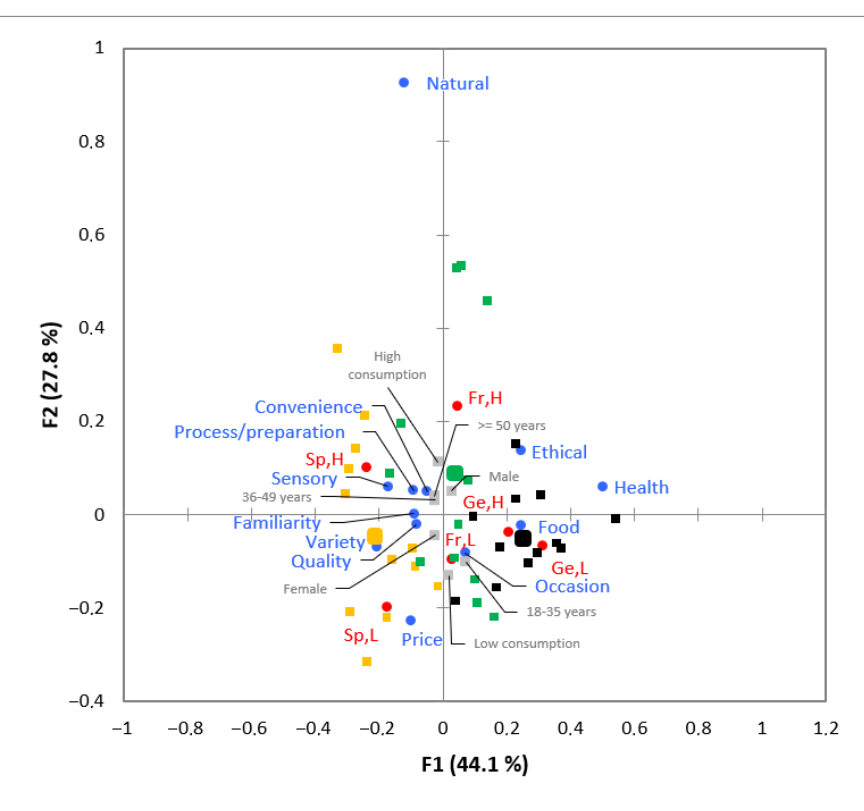
Figure 4. Correspondence analysis of the frequency of mention of the 12 dimensions and supple- mentary variables: high fish consumption (H); low fish consumption (L); black, German participants (Ge); yellow, Spanish participants (Sp); and green, French participants (Fr). Country totals are expressed in broader coloured points: light blue, dimensions; and light grey, supplementary variables.